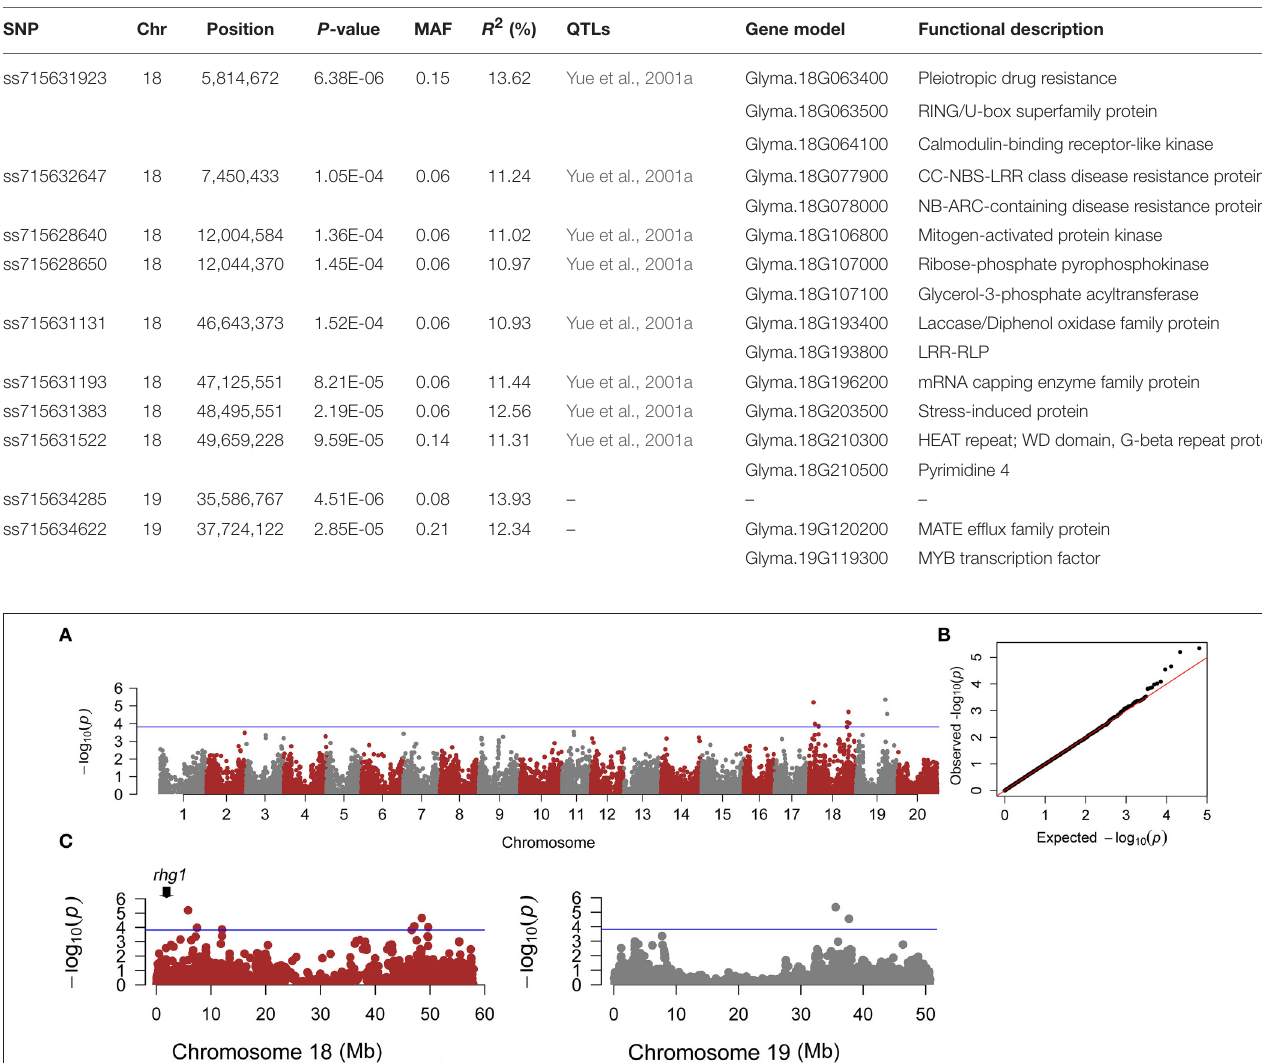
TABLE 1 | Significant SNPs and predicted candidate genes associated with SCN HG Type 2.5.7 resistance in G. soja.